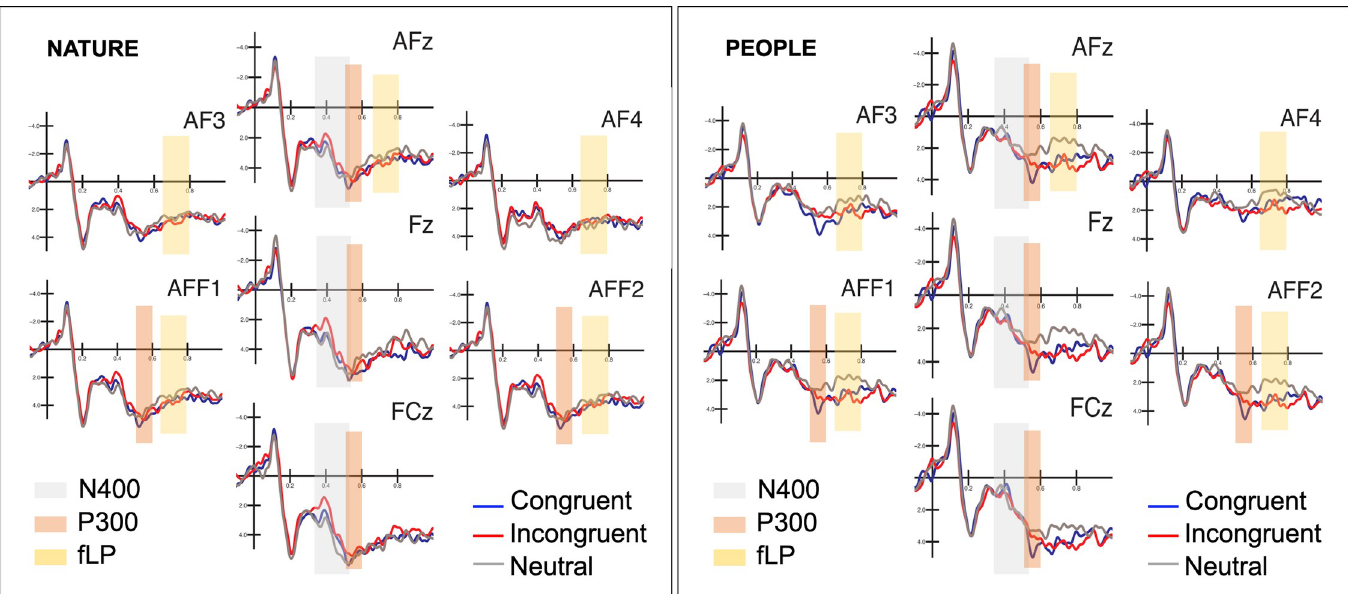
Fig 4. Grande average ERP waveforms recorded at anterior frontal sites in response to congruent, incongruent and neutral sentences. The time windows corresponding to the N400 (350–550 ms), P300 (500–600 ms) and frontal positivity (fLP; 650–800 ms) are highlighted. On the left recordings from the “Nature” group; on the right from the “People” group.